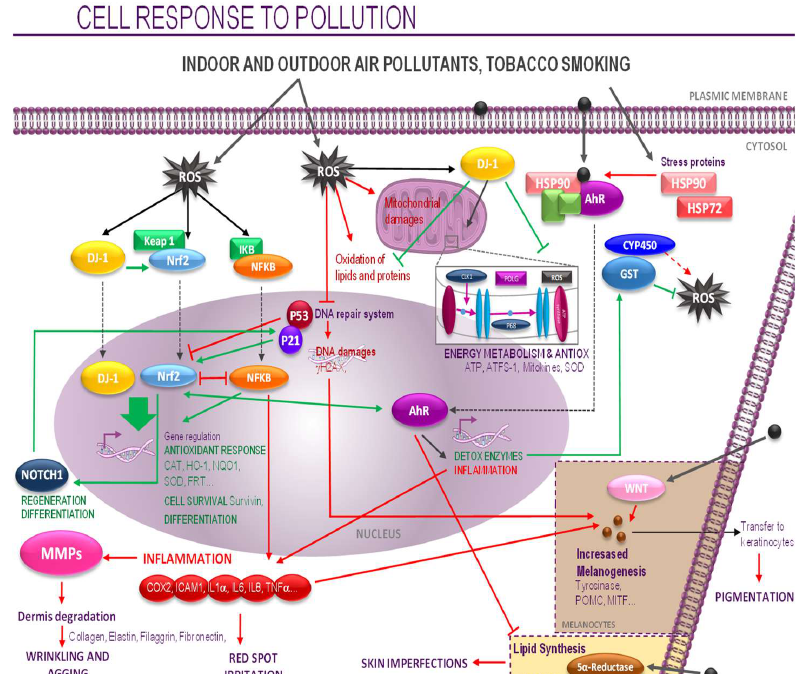
Figure 1. Signaling pathway responses to global pollution. Air pollutants induce Reactive Oxygen Species (ROS) generation and pro-inflammatory cytokines. Upon ligation by pollutants, the activated AhR translocates from the cytoplasm into the nucleus. This translocated AhR binds with ANRT, resulting in the activation of Cytochrome P450, family 1, member A1 (CYP1A1) transcription. ROS generated by CYP1A1 stimulates the production of TNF-α and IL-8. ROS also activates beneficial cellular responses, including Nuclear factor (erythroid-derived 2)-like 2 (Nrf2) activation. Under